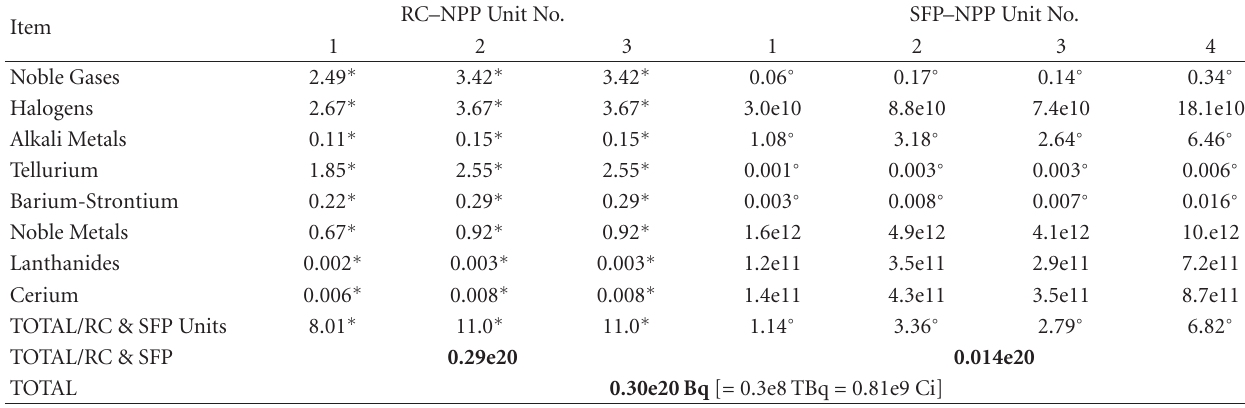
Table 6: Radioactivity inventory released to containment and reactor building of Fukushima Units 1 to 4.